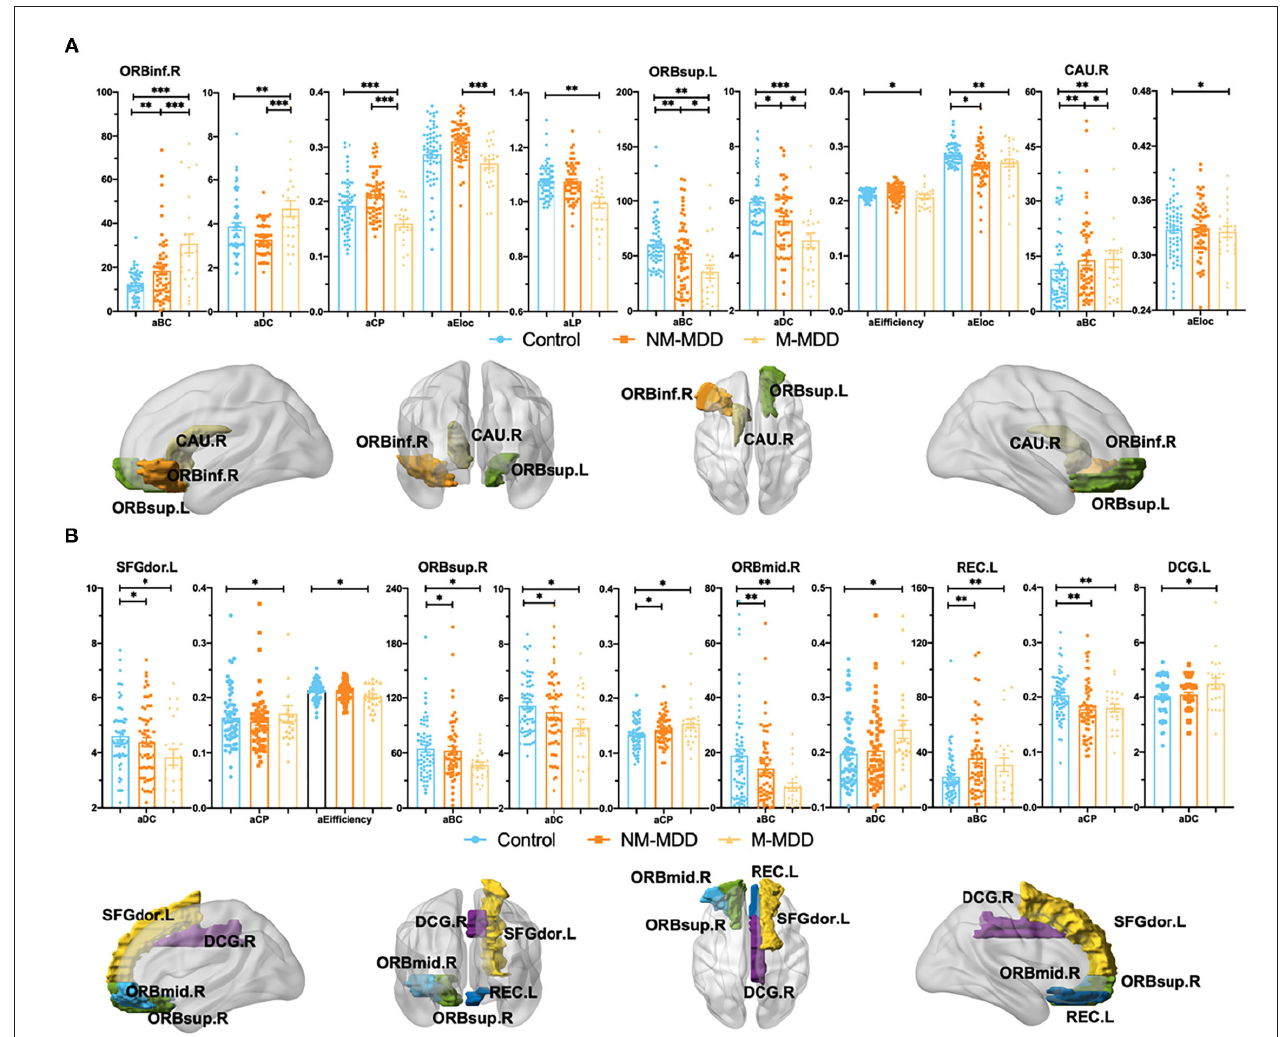
FIGURE 2 | Group comparison of Node attributes among NM-MDD, M-MDD, and control groups. (A,B) : MDD groups showed significantly decreased aBC (ORBsup.L, ANG.R, ORBsup.R and ORBmid.R), aDC (ORBsup.L, SFGdor.L and ORBsup.R), aEifficiency (ORBsup.L and SFGdor.L), aCP (ORBinf.R and REC.L), aEloc (ORBsup.L and CAU.R) and increased aBC (ORBinf.R, CAU.R and REC.L), aDC (ORBinf.R, ORBmid.R and DCG.L), and aCP (SFGdor.L and ORBsup.R). (A) Group comparison of Node attributes between NM-MDD and M-MDD showed abnormal brain regions in ORBinf.R ORBsup.L and CAU.R. (B) Only compared with the control group, MDD groups showed abnormal brain regions SFGdor.L, ORBsup.R,O RBmid.R, REC.L, and DCG.L. FDR corrected, * p < 0.05, ** p < 0.005, *** p < 0.0001. ORBinf (Orange, Orbital inferior frontal gyrus) ORBsup (Green, Orbital superior frontal gyrus), CAU (Earthy, Caudate nucleus), SFGdor (Yellow,